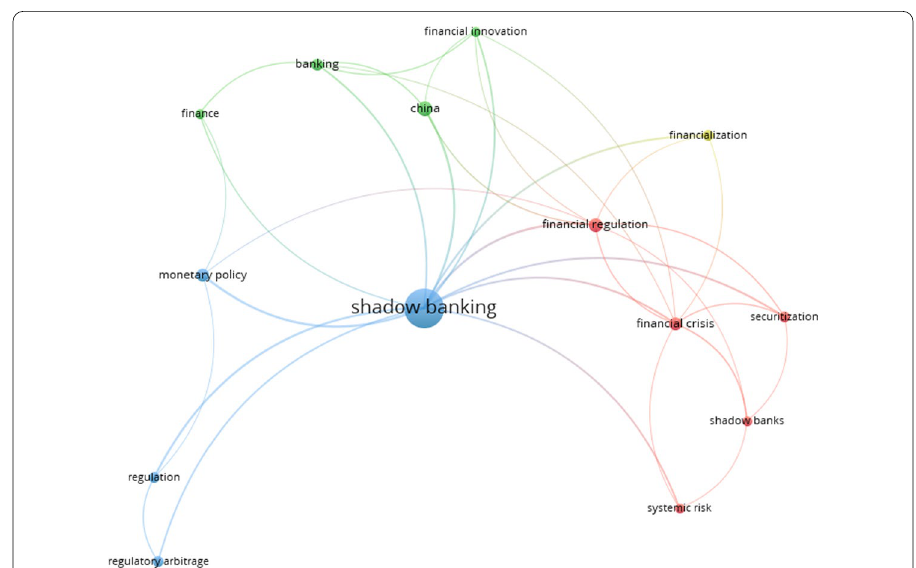
Fig. 4 Network map of co-occurrence of all keywords. Source : Authors’ own estimation